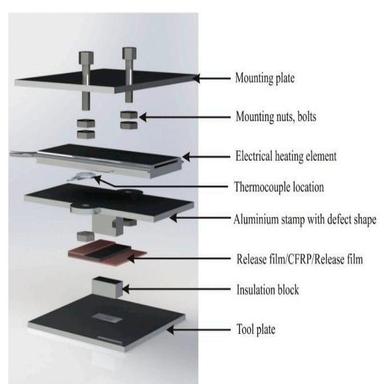
Exploded view of equipment used to pre-cure areas of individual plies.